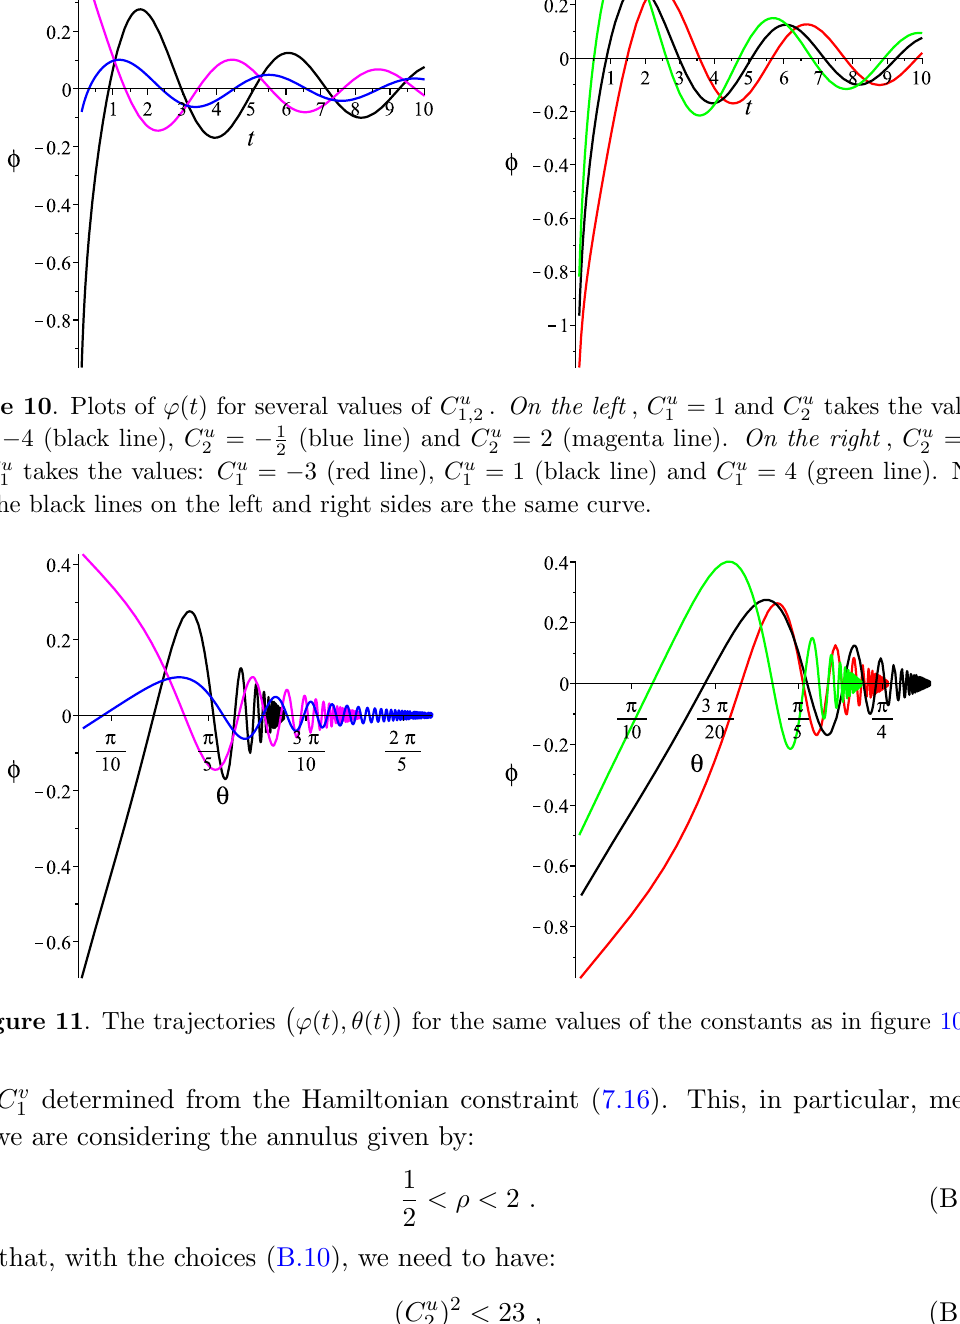
= 1 and C u takes the values: 1 2 = (cid:0) 4 2 = 4 (green line). Note 1